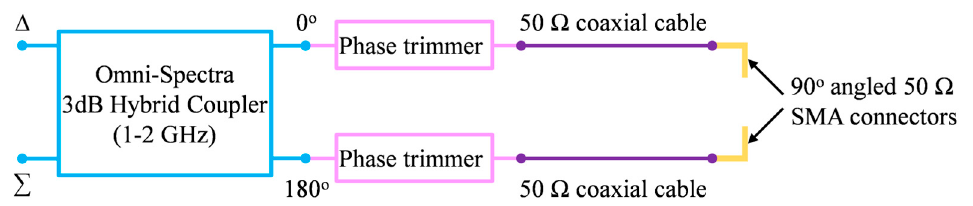
Figure 8. Schematic configuration of the differential feed network.